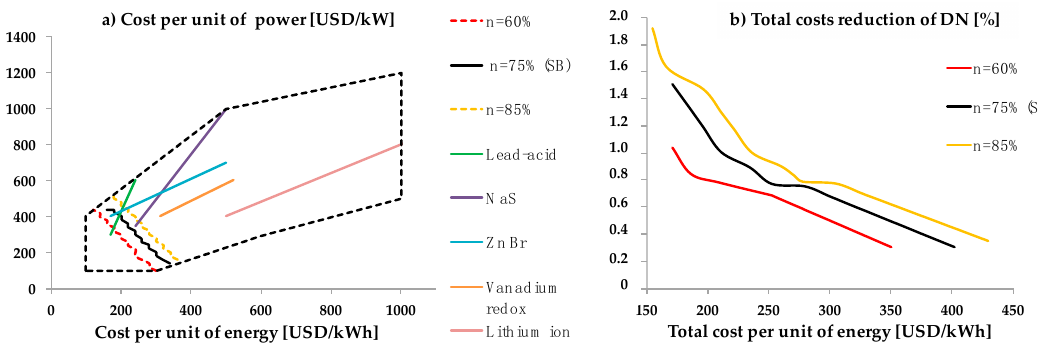
Figure 5. ( a ) Effects of the battery efficiency on the break-even costs and ( b ) Total cost reductions for the DN for different BESS efficiencies.